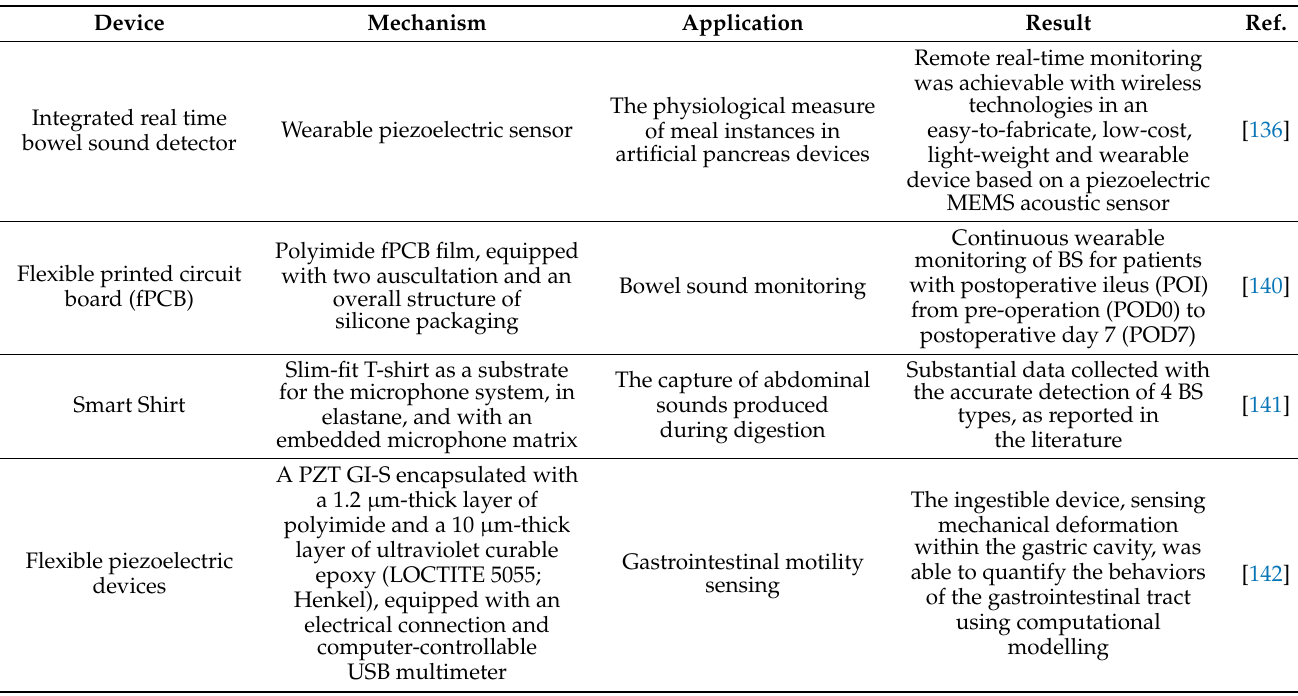
Table 5. Sensor equipment for gastrointestinal sound